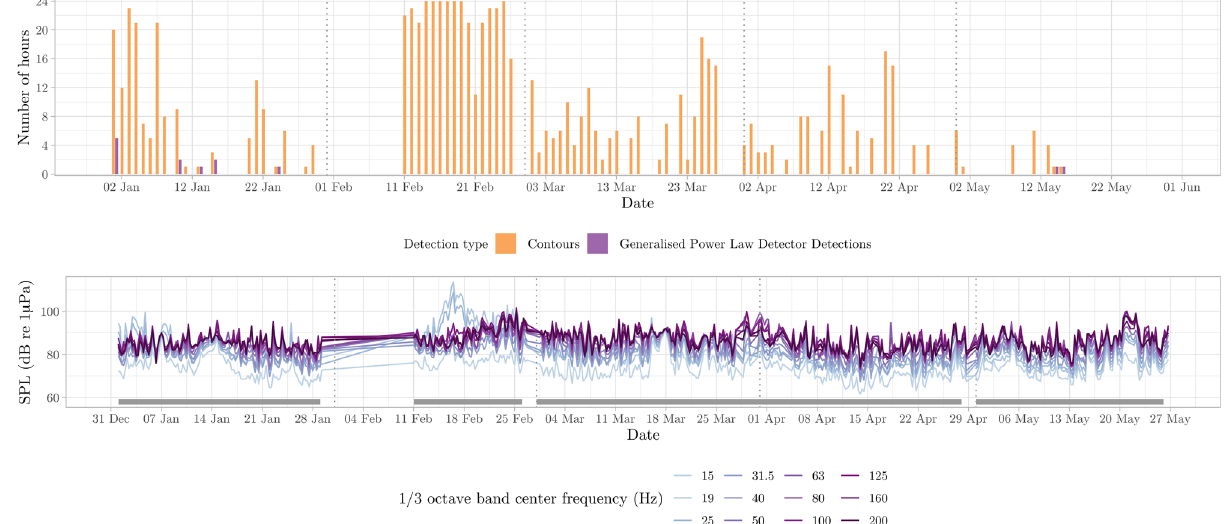
Figure 8. Number of detection hours per day for low frequency detections between 0 and 200 Hz, with detections for contours and generalized power law, representing low-frequency modulated signals generally associated to baleen whale species (top). Sound Pressure Level values for different 1/3 octave bands, grouped into six-hour averages for visibility purposes (bottom). Grey segment bars indicate the sampling effort in days (i.e., gaps represent lack of acoustic